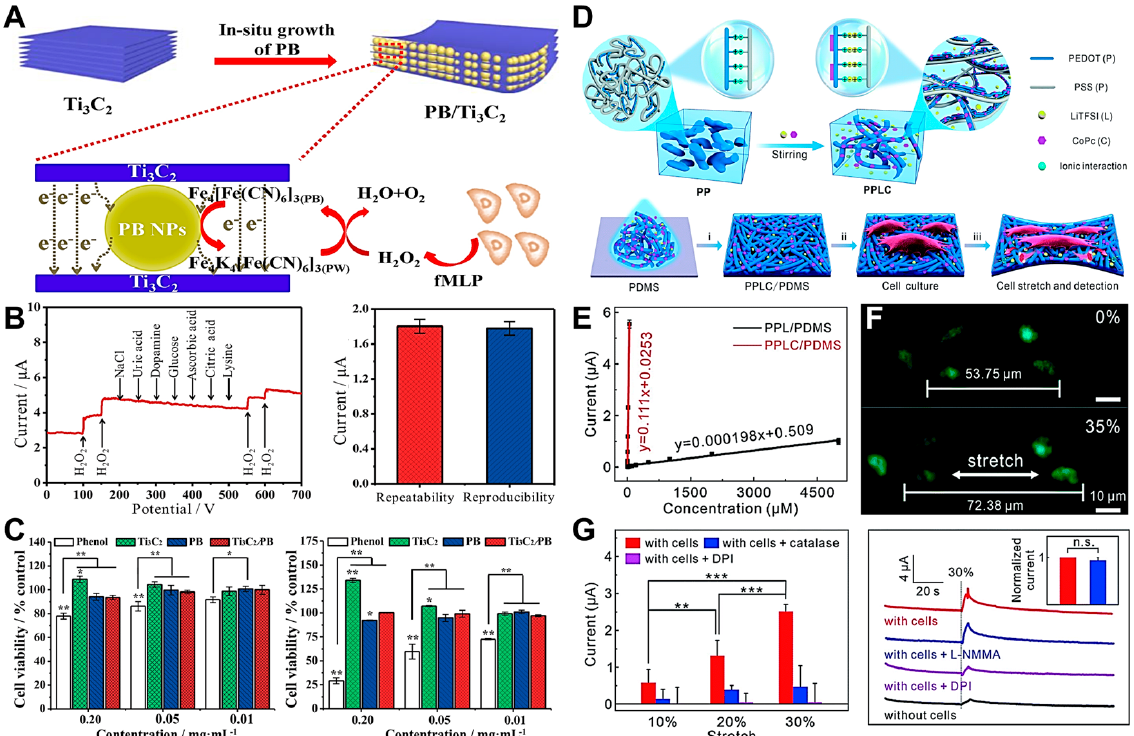
Figure 4. ( A ) Schematic of a PB/Ti 3 C 2 /GCE biosensor for detecting H 2 O 2 from live HeLa cells. ( B ) Amperometric I–T response of the PB/Ti 3 C 2 /GCE biosensor with the consecutive treatment of 100 μ M of H 2 O 2 (left panel). Current response of the amperometric detection for 0.2 mM of H 2 O 2 (right panel). ( C ) Cell viability of L929 cultured with different concentrations of nanomaterials for 5 h (left panel) and 48 h (right panel; * p < 0.05 and ** p < 0.01). ( D ) Schematic of the PEDOT:PSS platform functionalized with LiTFSI and CoPc for monitoring cells by detecting H 2 O 2 from live cells. ( E ) Calibration graph of the PPL/PDMS and PPLC/PDMS electrodes at various H 2 O 2 concentrations. ( F ) Representative fluorescent images of 16HBECs cultured on a PPLC/PDMS film stained with Calcein-AM (green) and PI (red) before and after they are stretched. ( G ) Amperometric responses detected from 16HBECs to various stretch stimuli (left panel), and 30% strain with various treatments at a potential of +0.55 V (vs. Ag/AgCl; right panel). Reprinted with permission from [77]. Copyright 2020, Elsevier; reprinted with permission from [76]. Copyright 2021, Royal Society of Chemistry.